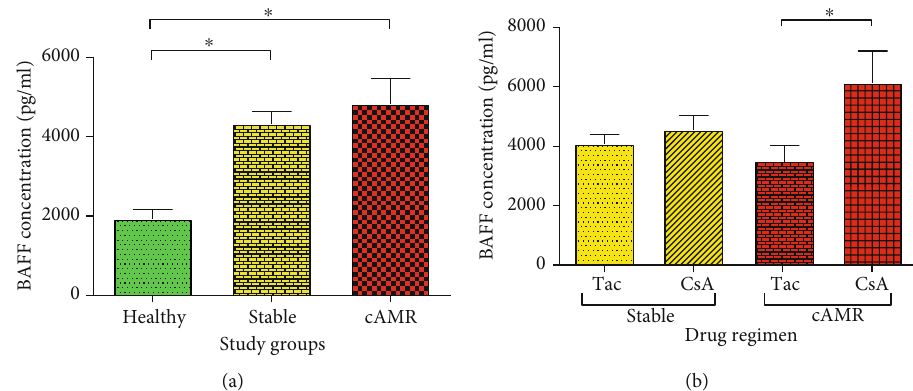
Figure 5: BAFF serum level in healthy individuals, patients with stable graft function, and cAMR patients (a). BAFF serum level in transplanted patients with di ff erent immunosuppressive drug, tacrolimus (Tac), or cyclosporine A (CsA) (b). Error bars represent SEM ( ∗ P ≤ 0 : 05